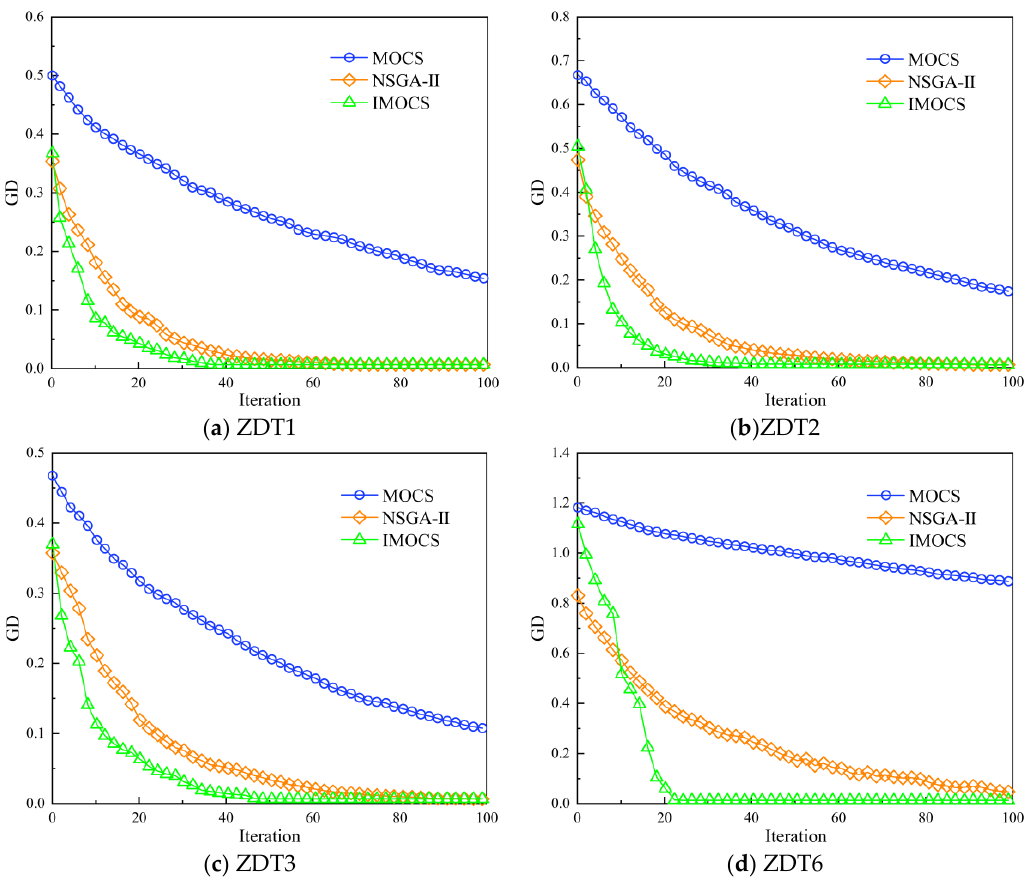
Figure 17. Comparison of convergence speed.